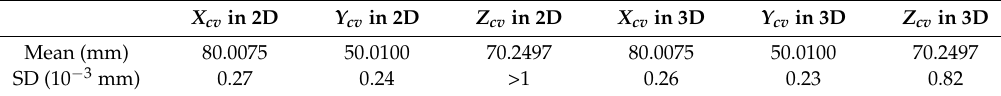
Figure 9. Simulated circle captured by the VC. Table 1. Circle centers and errors.